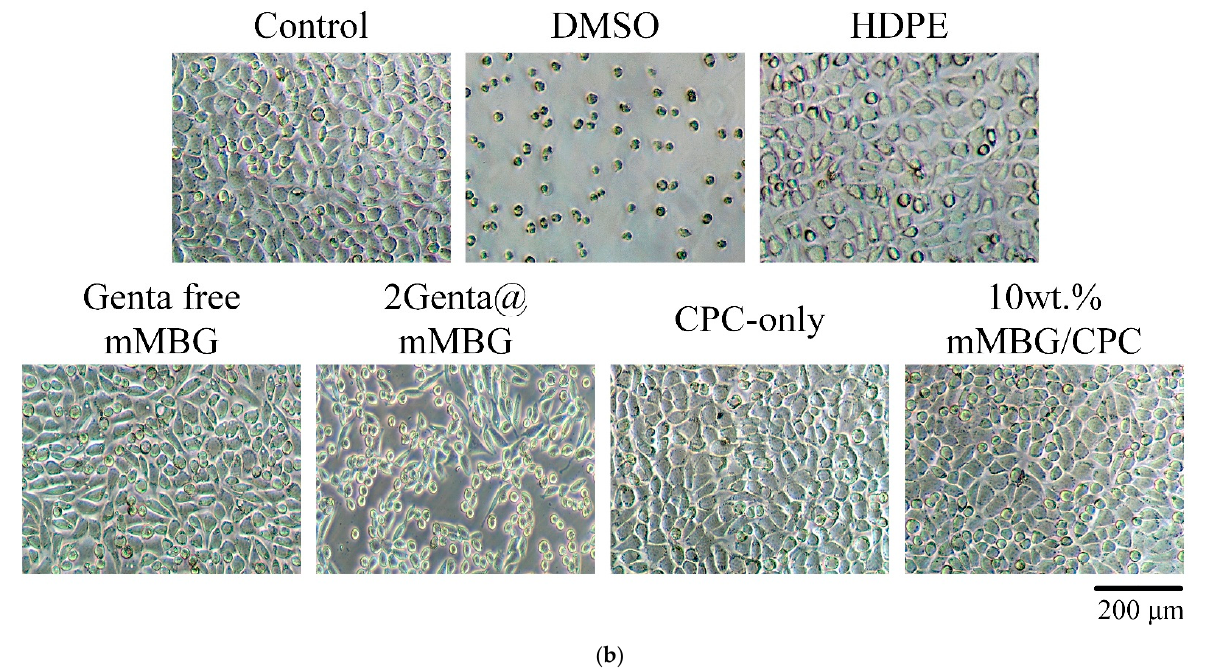
Figure 8. Extracts cultured with L929 cells for 1 day; ( a ) quantitative ( n = 3) and ( b ) qualitative analysis of Genta-free mMBG and antibiotic impregnation (2Genta@mMBG); CPC-only, and 10 wt.% mMBG/CPC composite bone cement.